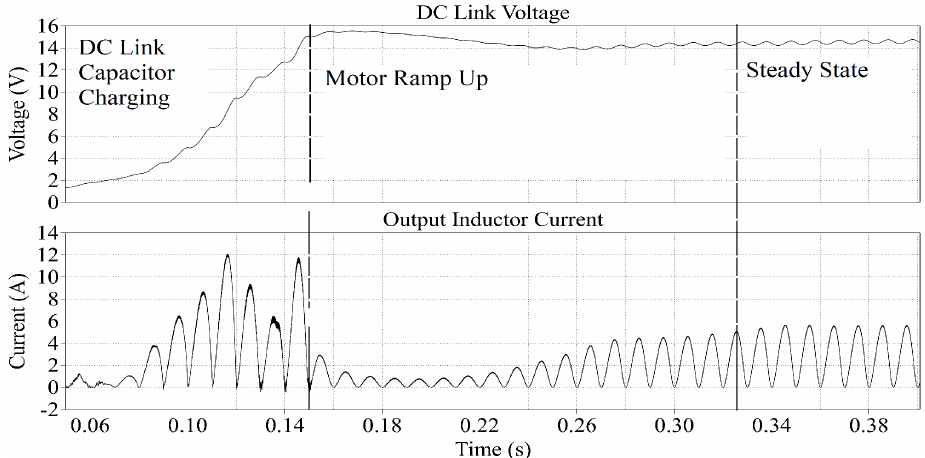
Figure 11. Time domain simulation of the converter depicting the output voltage V o and output inductor current i o